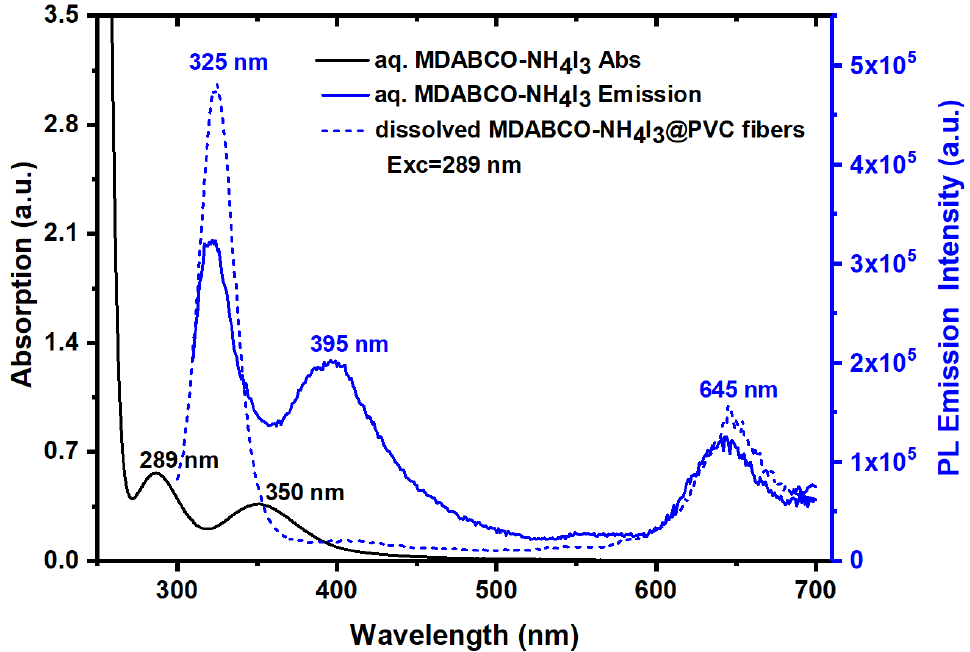
Figure 8. Optical absorption and photoluminescence emission of MDABCO-NH 4 I 3 aqueous solution (3 mg/mL) and MDABCO-NH 4 I 3 @PVC nanofibers dissolved in tetrahydrofuran. The excitation wavelength for PL measurements were 289 nm.